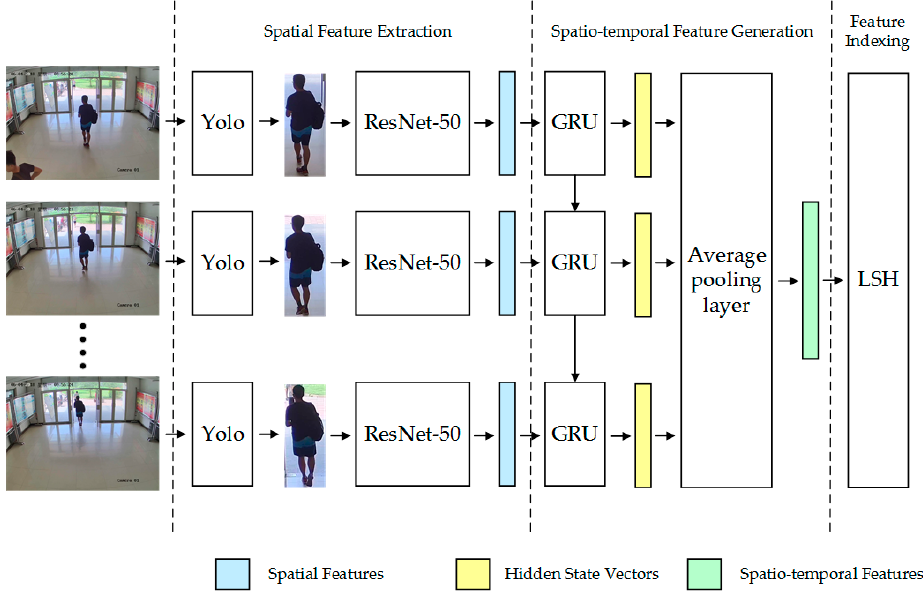
Figure 1. The framework of the proposed person search method.